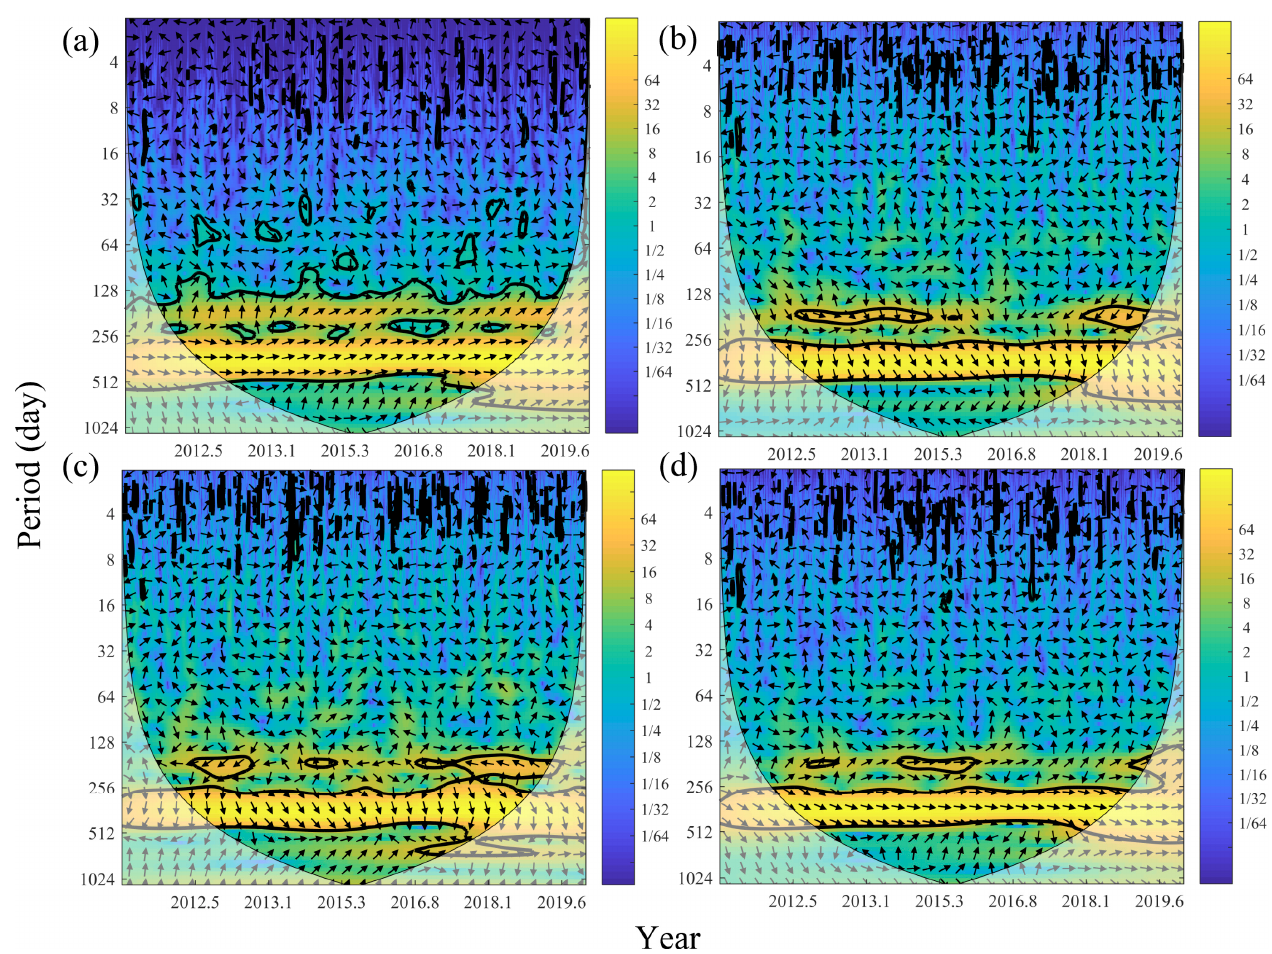
Figure 10. The cross wavelet power spectrum between GPS and HYDL ( a ), ATML ( b ), NTOL ( c ), and their combined ( d ) time series at YNCX station. The color bar represents the spectrum energy. The thin, black lines represent the COI delimiting the region not influenced by edge effects. Thick, black contours represent the significance test at the 95% level.